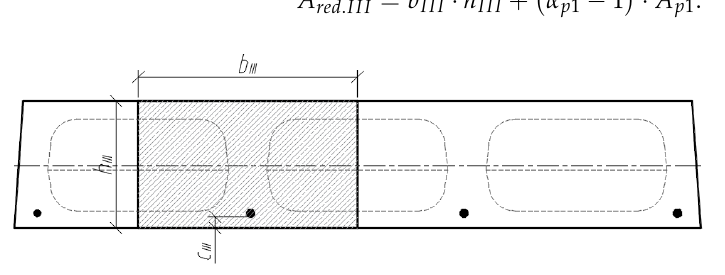
Figure 12. Analysed cross-section III-III.